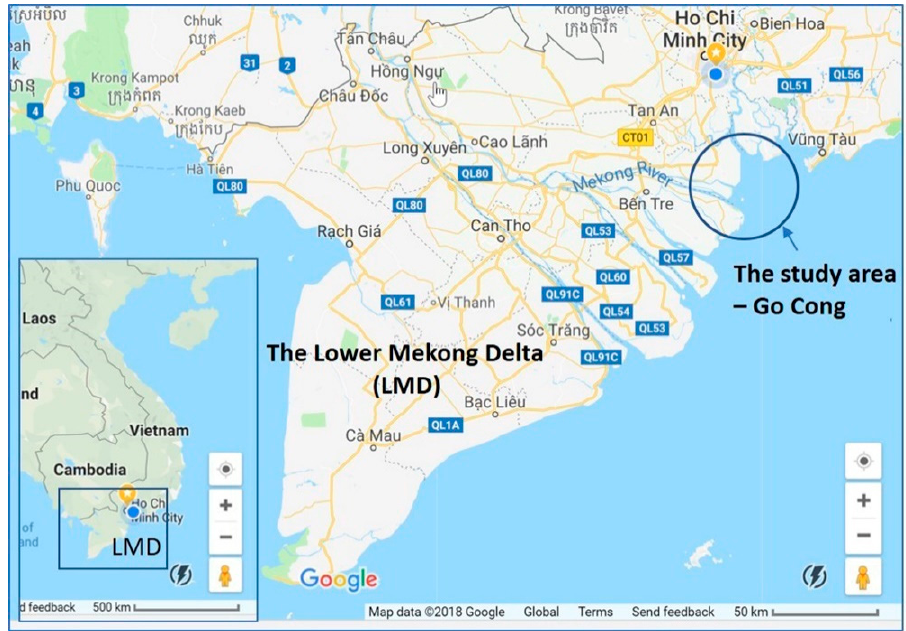
Figure 1. The Lower Mekong Delta (LMD) and the study area—Go-Cong (from maps.google.com, accessed on 10 November 2016).